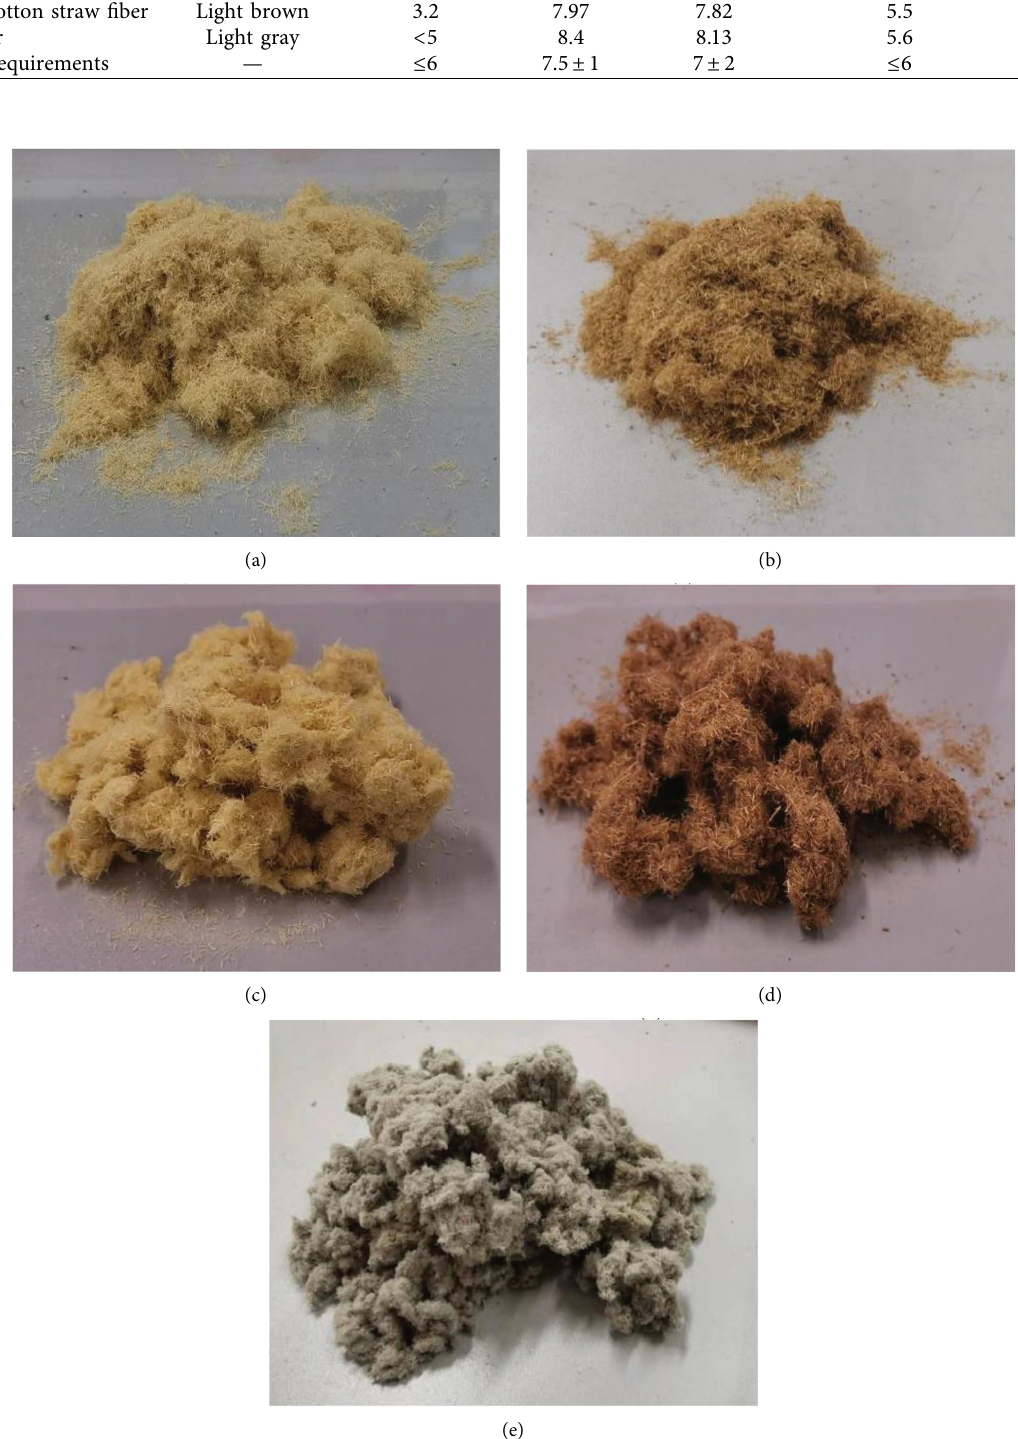
Figure 4: Appearance of fbers. (a) Corn straw fber. (b) Cotton straw fber. (c) Modifed corn straw fber. (d) Modifed cotton straw fber. (e) Lignin fber.